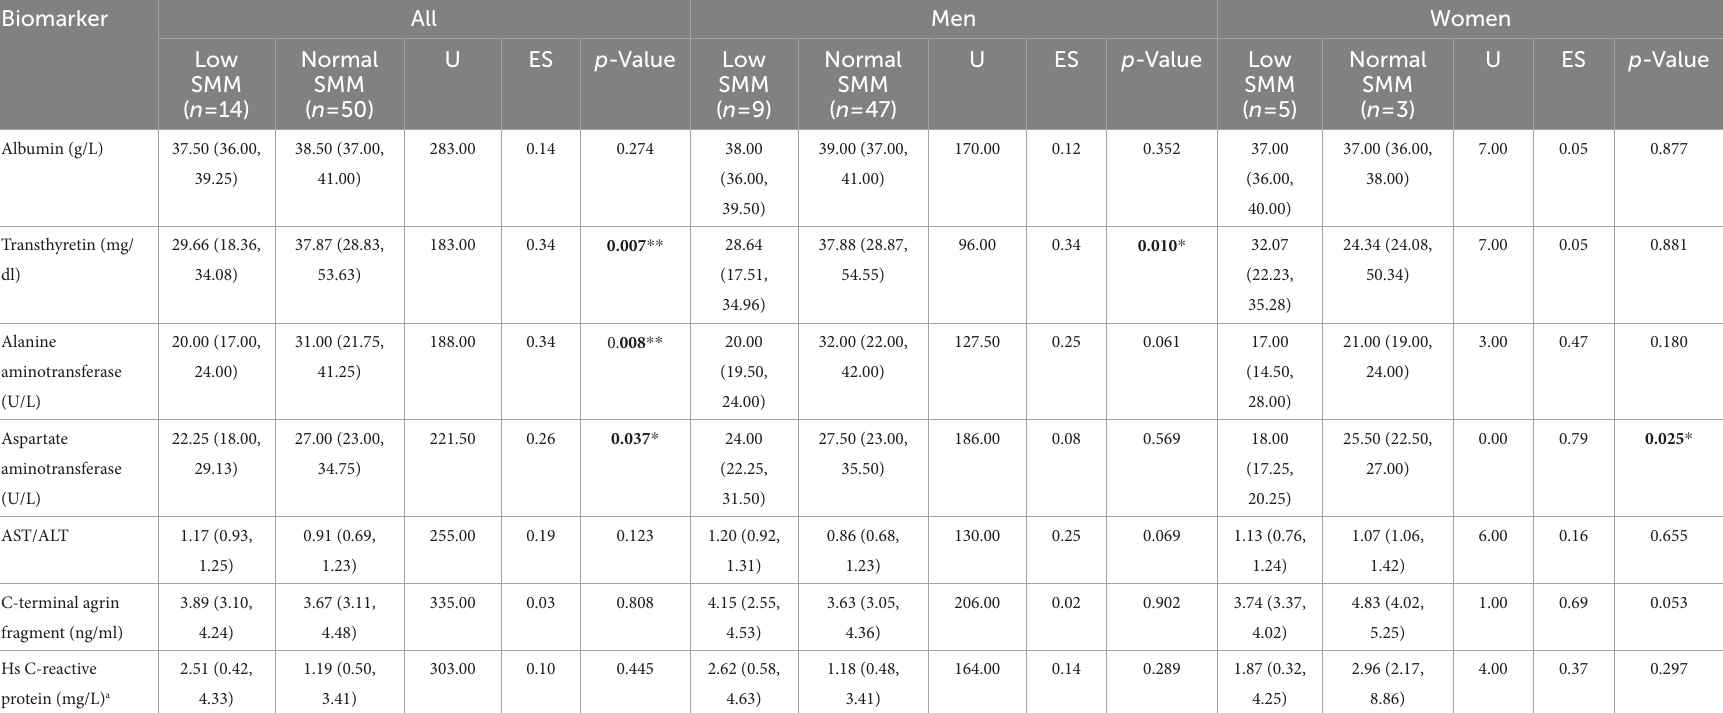
TABLE 2 Circulatory biomarker concentrations in people with coronary heart disease with low or normal skeletal muscle mass (SMM). Biomarker All Men